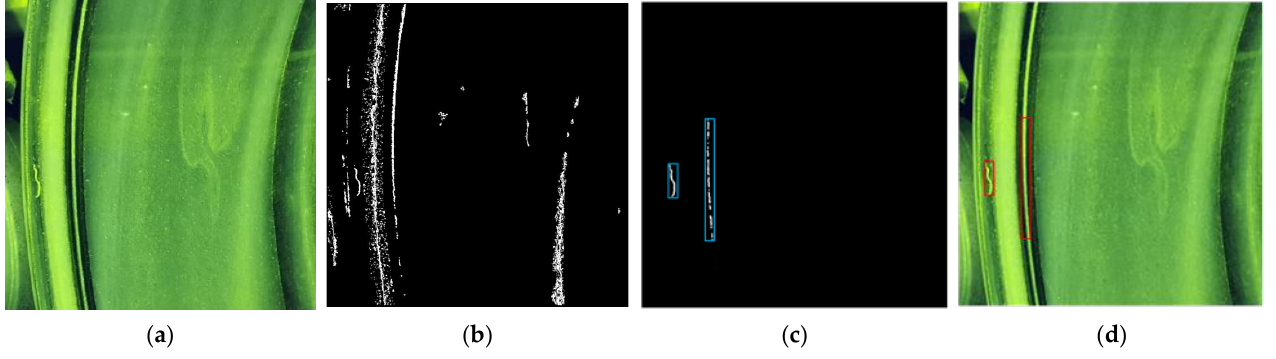
crack is acquired, which reduces the computation of the CNN model.